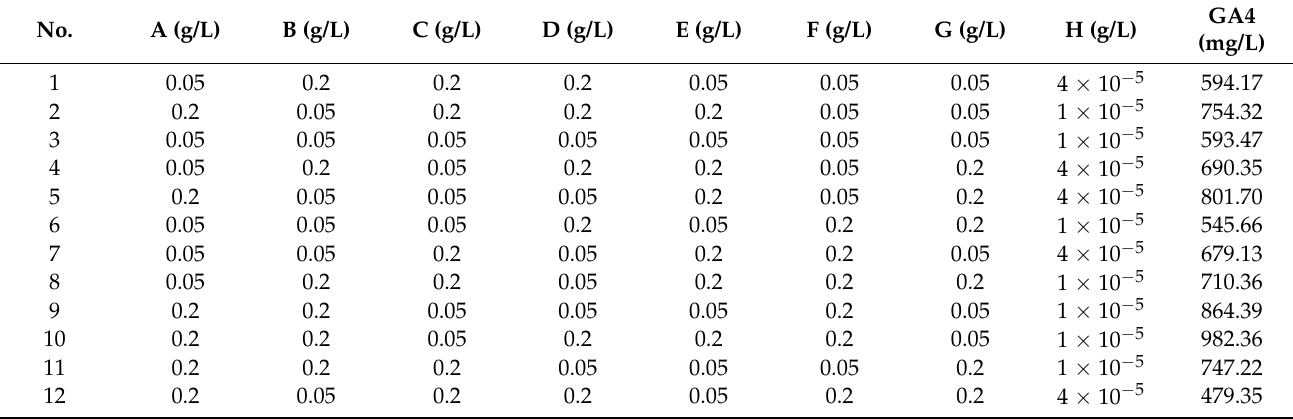
Table 6. Experimental design using PB of eight independent variables with their concentration and actual values of GA4